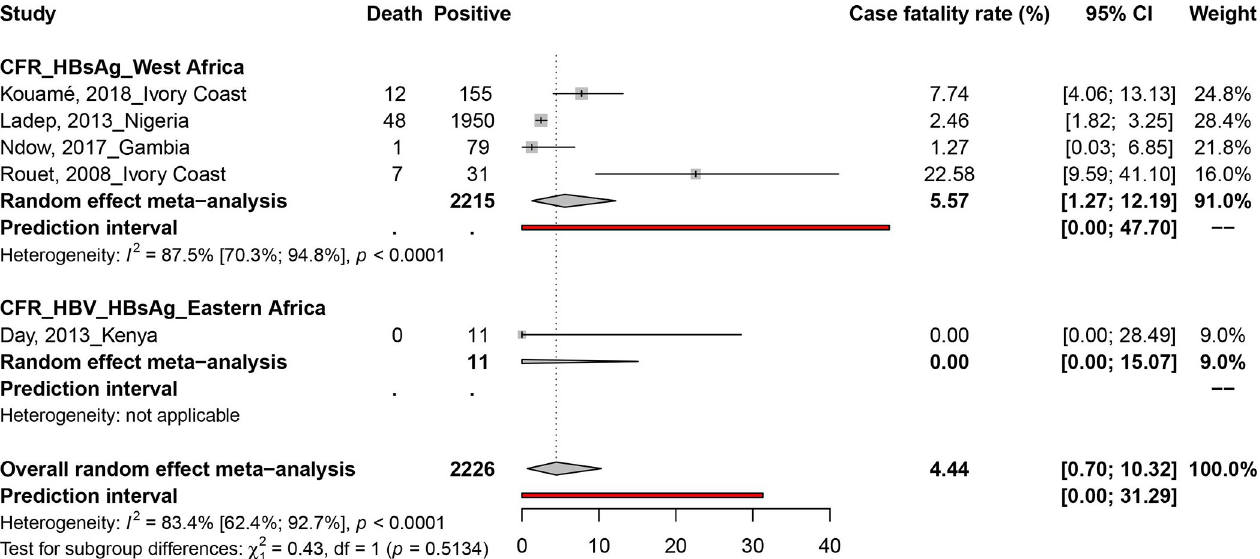
Fig 3. Case fatality rate estimate of hepatitis B virus infections in people living with HIV in Africa.